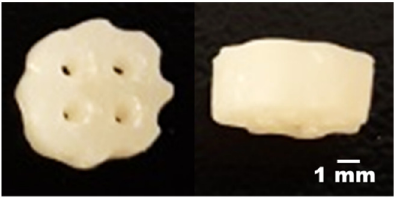
Figure 6. The images of the printed scaffold with the optimization parameter.